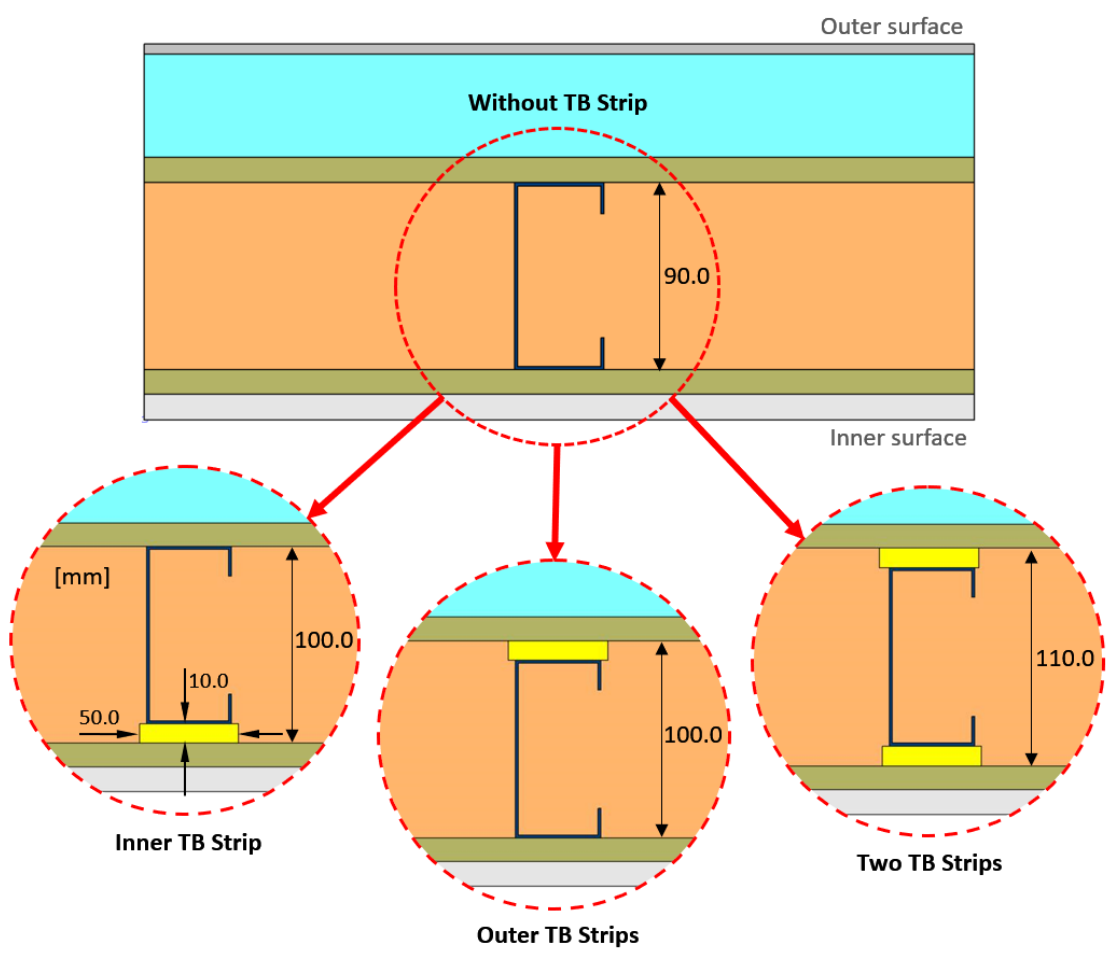
Figure 2. Geometry and location of the thermal break (TB) strips.